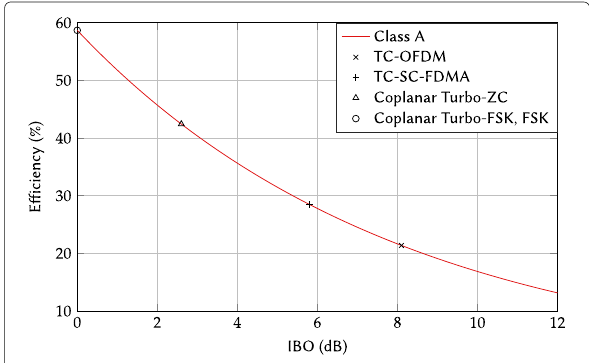
Fig. 8 Drain efficiency versus IBO for class A amplifier, and efficiencies of the five compared solutions for the given